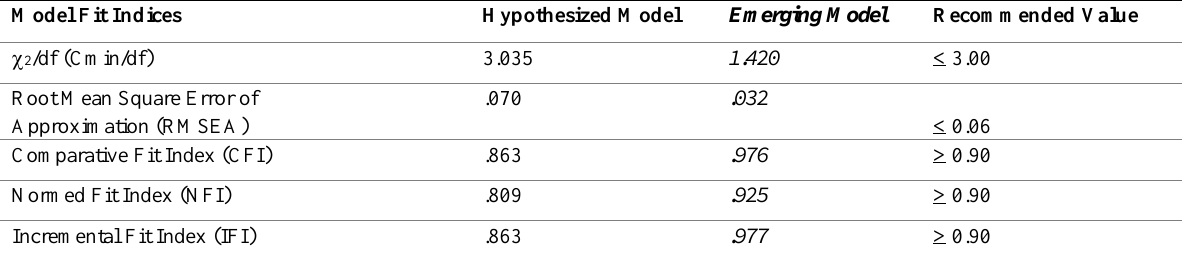
Table 1: Model Fit Indices of Hypothesized and Emerging Model